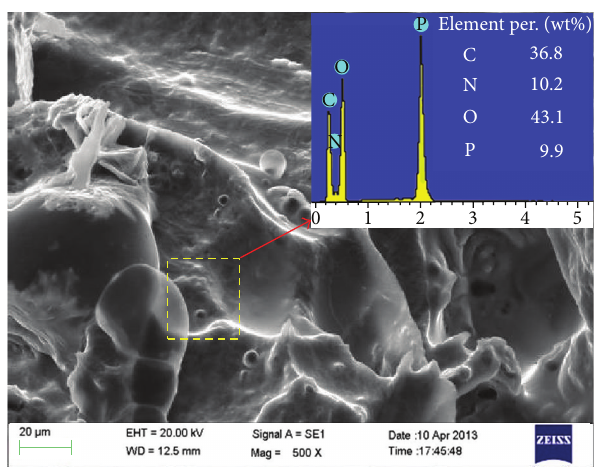
Figure 11: SEM-EDXS image of the outer char surface for the PP-6 after the cone calorimetric test.